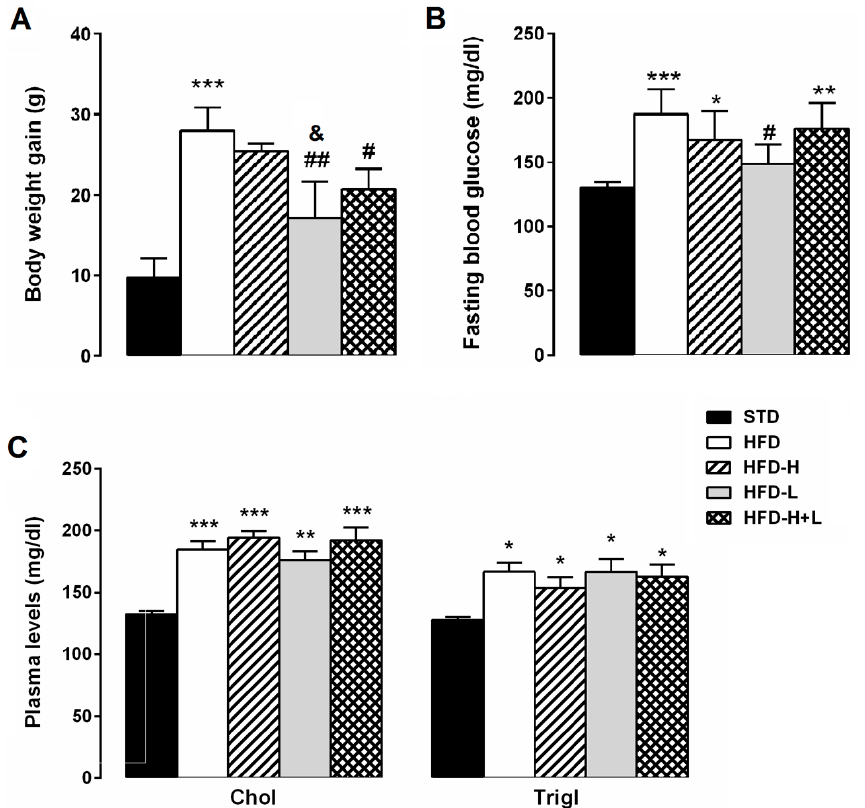
Figure 1. Metabolic parameters. ( A ) body weight gain, ( B ) fasting blood glucose concentrations and ( C ) plasma levels of cholesterol and triglycerides in obese mice. Data are mean values ± S.E.M. ( n = 8/group). * p < 0.05, ** p < 0.01, *** p < 0.001 vs. STD mice; # p < 0.05, ## p < 0.01; & p < 0.05 vs. HFD-H mice.